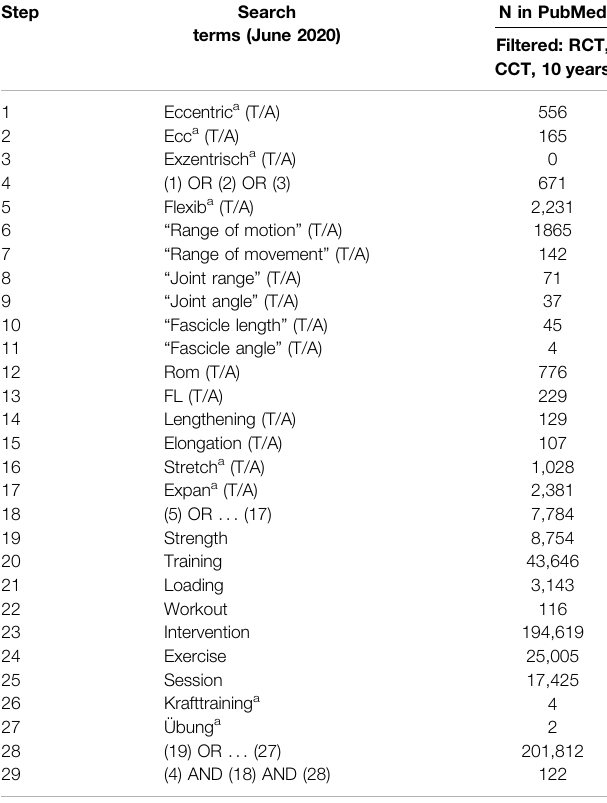
TABLE 1 | Example for the development of search